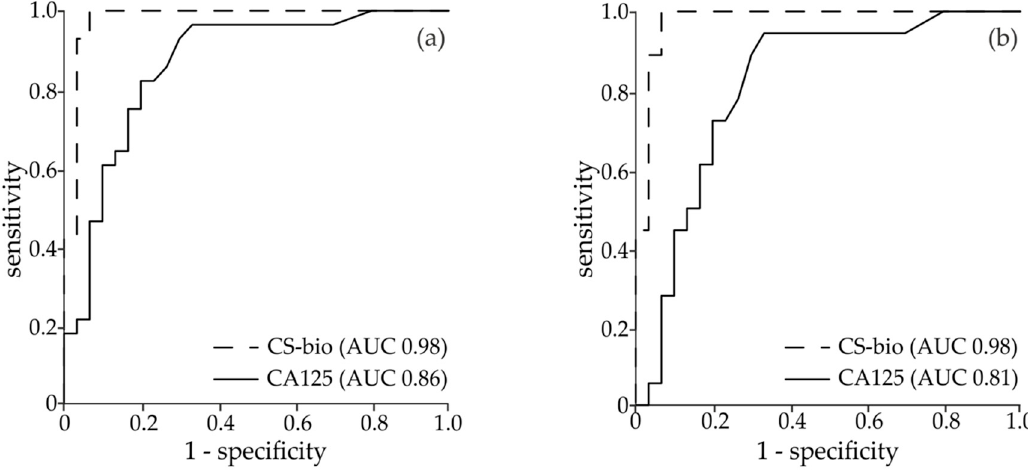
Figure 2. ROC curves of the biomarkers CS-bio and CA125 for ( a ) all EOC ( n = 26) and control samples included in this study ( n = 30) and ( b ) early stage (FIGO I + II, n = 18) and control samples ( n = 30).